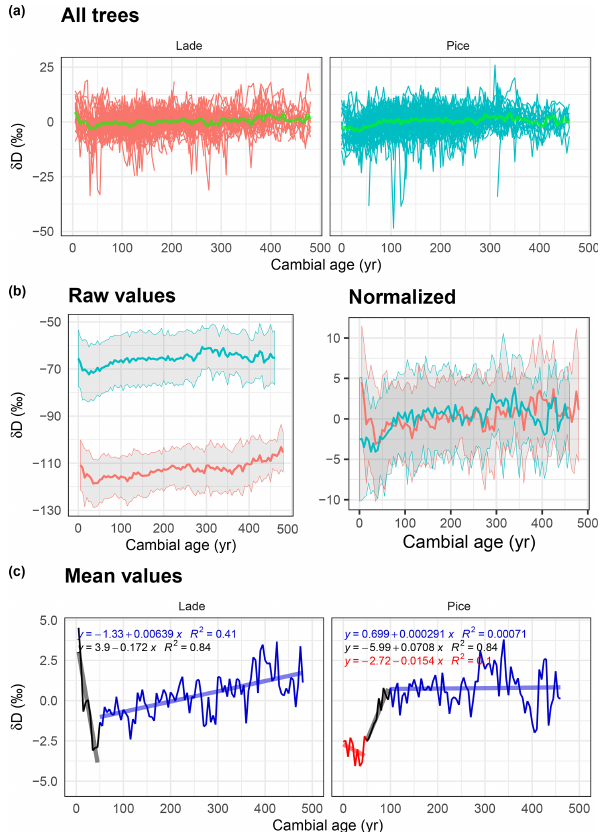
Figure 6. Analysis of tree-ring width (TRW) data: (a) raw TRW val- ues of all larch (LADE, red) and cembran pine (PICE, green) trees, green line corresponds to the mean. (b) Raw (left) and normalized (right) mean value with corresponding ± 1 standard deviation (gray area) of larch (red) and cembran pine (cyan). (c) Plots of the mean values with linear approximations for the periods 1–50 to 50–100, 101–300, and > 300